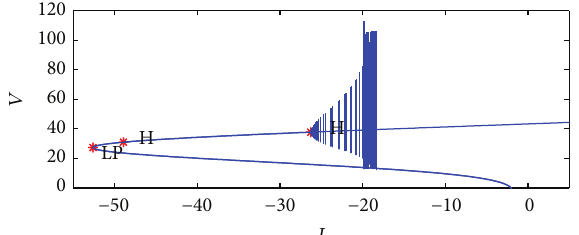
Figure 7: The limit cycle emerging from uH at 𝐼 = −26.281425 .